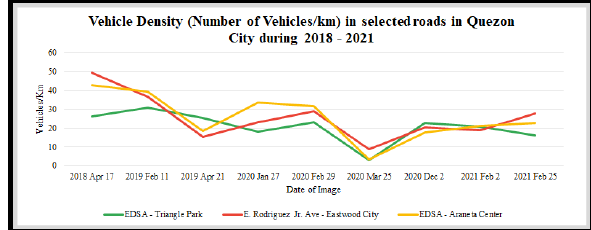
Figure 10. R Vehicle Density (Number of Vehicles/Km) in select roads in Quezon City during 2018 -